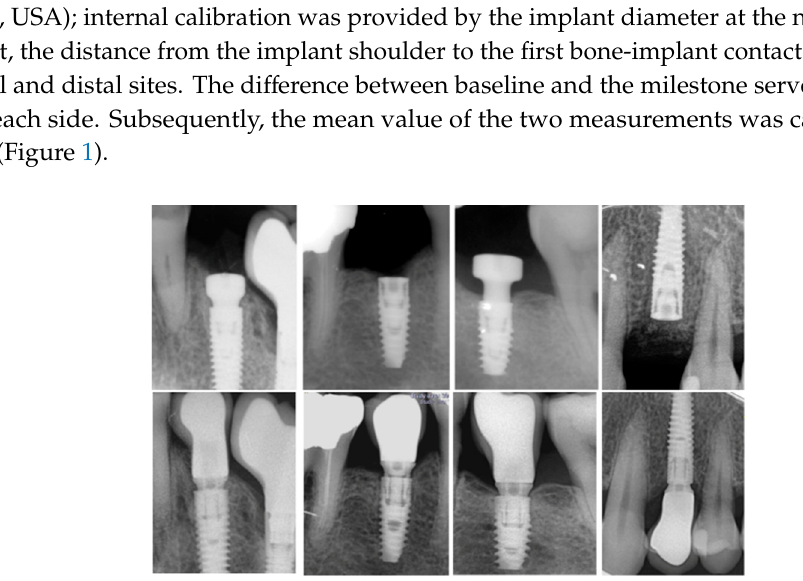
Table 1. Variables recorded in this study.